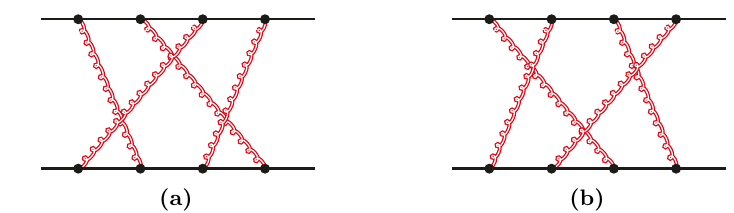
Figure 11. Diagrammatic representation of the irreducible configurations: (a) d A in eq. (C.3) and (b) d in eq. (C.4). B